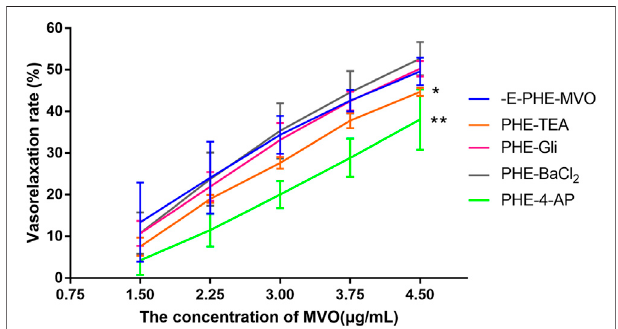
FIGURE 8 | In fl uences of different K + channel inhibitors, including Ca 2+ - activated K + (K Ca ) channel inhibitor TEA (10 mM), voltage-dependent K + (K V ) channel inhibitor 4-AP (1 mM), ATP-sensitive K + (K ATP ) channel inhibitor glyburide (10 μ M), and inward recti fi er K + (K IR ) channel inhibitor BaCl 2 (100 μ M) on MVO-produced relaxant effects in -E aortic rings precontracted withPHE(10 μ M).Thealternationoftensionwasexpressedasthepercentage of the active contraction induced by PHE (1 μ M). n = 6. Means ± S.D. * p < 0.05, ** p < 0.01 vs. -E-PHE-MVO group.